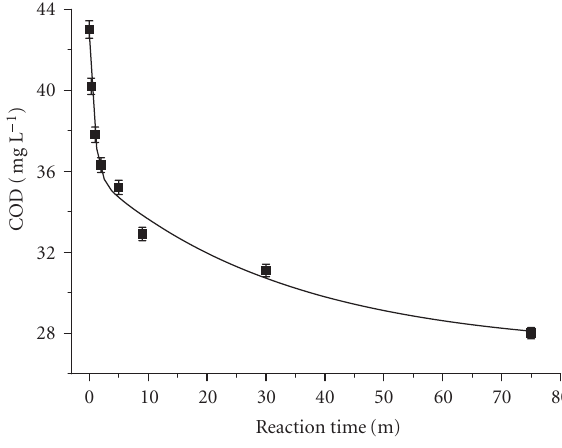
Figure 2: COD abatement of a solution of 0 . 119 mmol L 1 chlor- bromuron as a function of solar irradiation time. ( (cid:2) ) corresponds to the experimental data. (—) corresponds to a plot obtained from the best fit of the experimental data using the exponential decay second-order